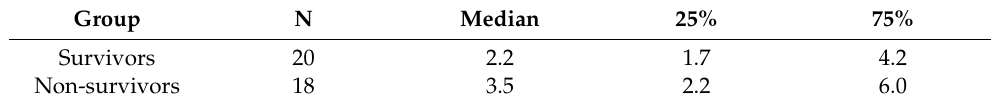
Table 6. Results of lactate levels (mmol/L) depending on survival. Control group was not included. Group N Survivors